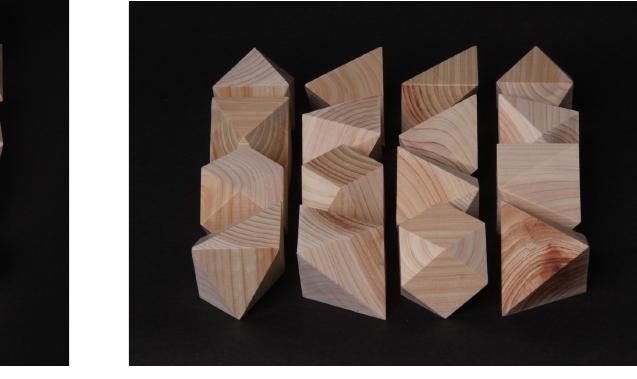
Woodworks by Hiroshi